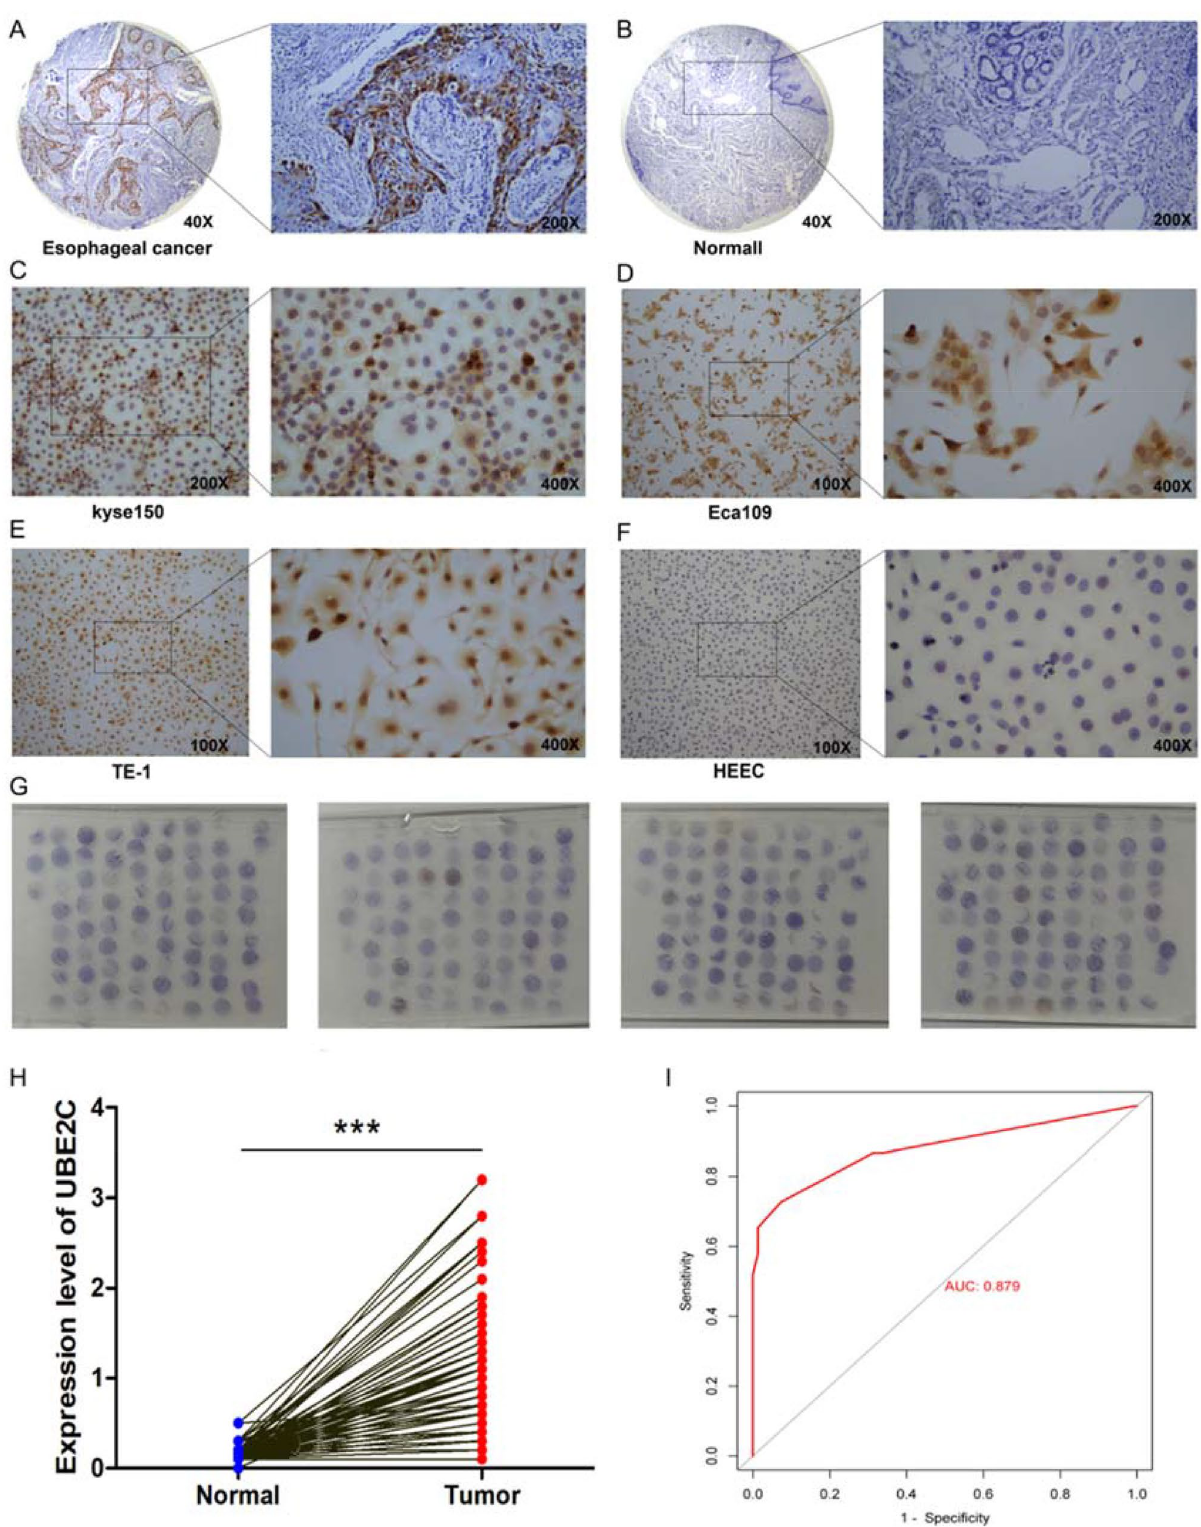
Figure 11. Immunohistochemical staining of UBE2C in the tissues and cell lines of the EC. ( A ) Expression of UBE2C in the EC. ( B ) Expression of UBE2C in normal esophageal tissues. ( C ) Expression of UBE2C in esophageal cancer cell line kyse150. ( D ) Expression of UBE2C in esophageal cancer cell line Eca109. ( E ) Expression of UBE2C in esophageal cancer cell line TE-1. ( F ) Expression of UBE2C in HEEC (normal esophageal cell line) . ( G ) Expression of UBE2C in the tissue microarray assay of 150 patients with esophageal cancer. ( H ) Differential expression analysis of UBE2C in cancer and adjacent tissues in the tissue microarray assay. Paired sample t -test was used to compare cancer and adjacent samples. *** P < 0.001. ( I ) Subject operating characteristic (ROC) curve analysis and area under curve (AUC) statistics were used to evaluate the ability of UBE2C to distinguish esophageal cancer from adjacent normal